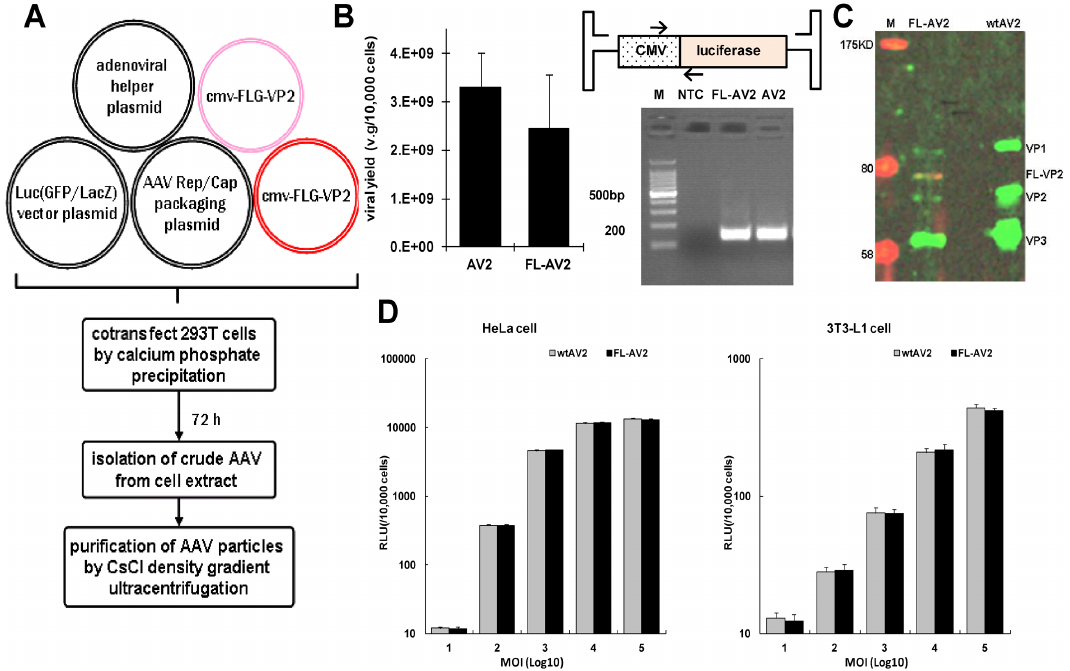
Fig 2. Preparation and characterization of recombinant AAV2 with FLAG-tagged capsid proteins. (A) Scheme of the AAV packaging system by cotransfection of 4 plasmids in 293T cells. (B) Comparison of the viral package yields of the 4-plasmid system (pAV-Luc:pAAV-RC:pAV-Helper: pCMV-FLG-VP2 at 1:1:1:10) with those from the conventional 3-plasmid approach (pAV-Luc:pAV-RC:pAV-Helper of equal amounts) to produce conventional viruses. The design of specific primers and their qPCR products in 2% gel electrophoresis were shown. (NTC: no template control) (C) Determination of the FLAG-VP2 incorporation in the purified FL-AV2 by western blot with the B1 anti-VP antibody (green) and anti-FLAG antibody (red). (D) Comparison of recombinant FL-AV2.Luc with regular AV2.Luc of the abilities to transduce HeLa cells (left panel) or 3T3-L1 cells (right panel). The infection doses from 1×10 1 to 1×10 5 virions per cell were used. The chemiluminescence measurements were carried out at 48 h after infections.